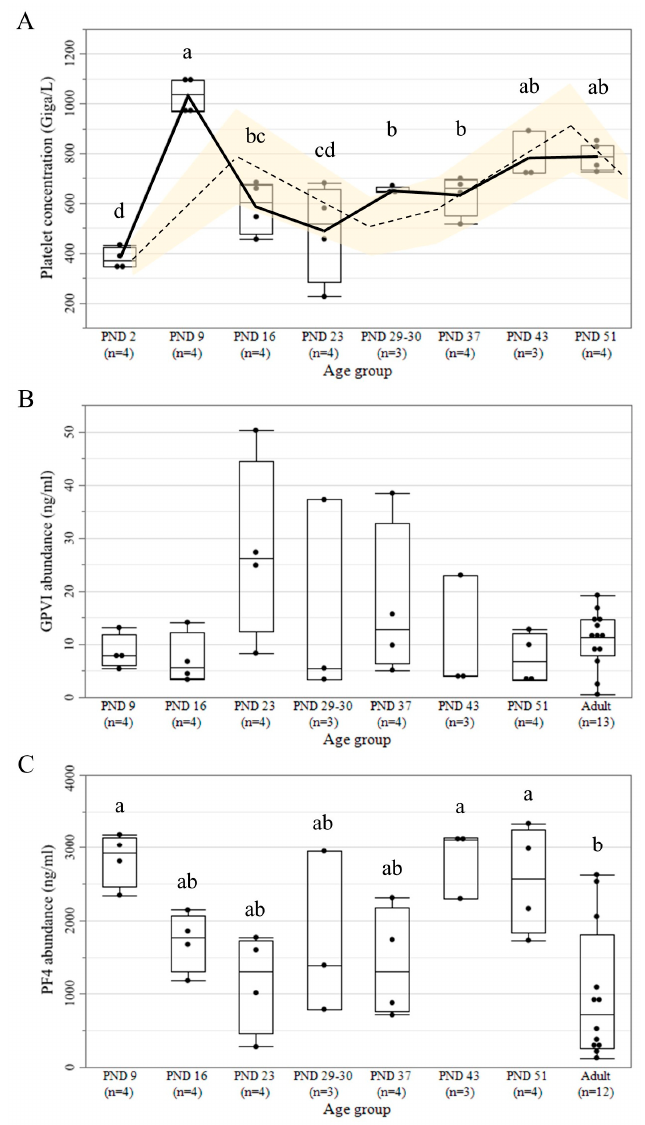
Figure 4. ( A ) Platelet concentration. The full trend line represents the platelet count from the juvenile minipig samples [30], whereas the broken trend line (mean) represents the normal platelet concentration range (yellow band) previously reported in the Göttingen minipig [43,46–48]. ( B ) GPVI, and ( C ) PF4 protein abundance over time in the juvenile and adult Göttingen minipigs. Age groups not sharing the same letter are significantly different by a linear mixed model, with Tukey’s honest significance difference post hoc ( p < 0.05).